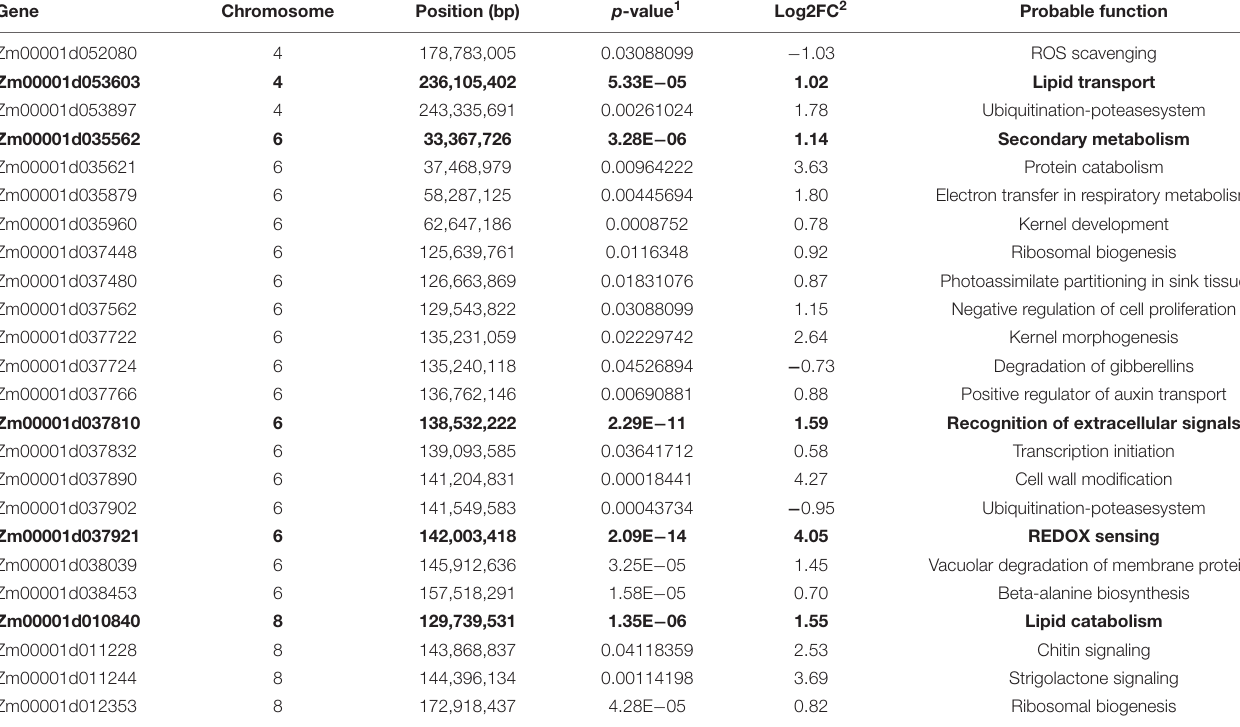
FIGURE 6 | qRT-PCR expression levels of susceptible and resistant inbred bulks for seven genes (A–G) . Each bar represents the normalized (referred to gap gene expression) expression level of the gene. Student’s t -tests were performed for comparing inbred bulk expressions, and differences between resistant and susceptible inbred bulks were significant at p < 0.05 for the seven genes. TABLE 2 | Candidate genes (more probable in bold) for QTL for fumonisin content and/or FER referred to the reference genome B73 RefGen_v4.